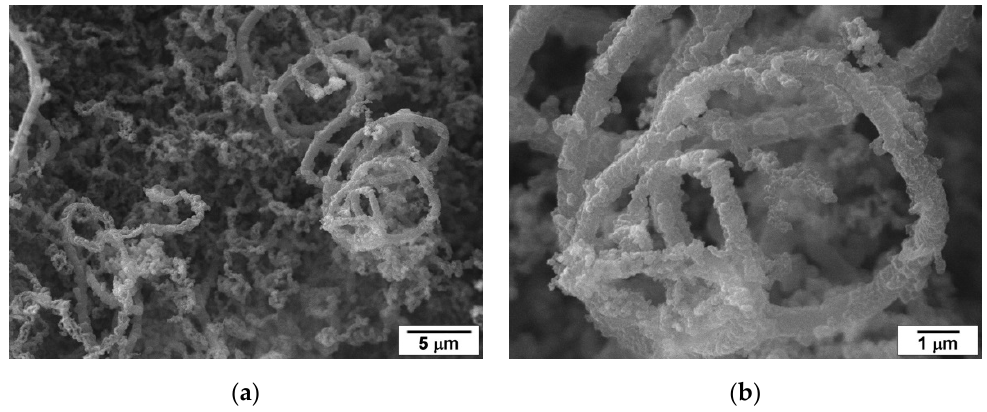
Figure 9. SEM images of the carbon nanofibers deposited over Ni/Al 2 O 3 catalyst during the processing of CHCl 3 in the presence of H 2 (40 vol%) at 550 °C at different magnifications: ( a ) ×1000 and ( b ) ×5000.